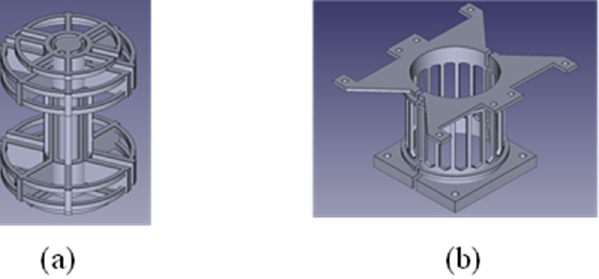
Figure 16. New support geometry for air-forced convection: ( a ) Inside part; ( b ) Outside part.